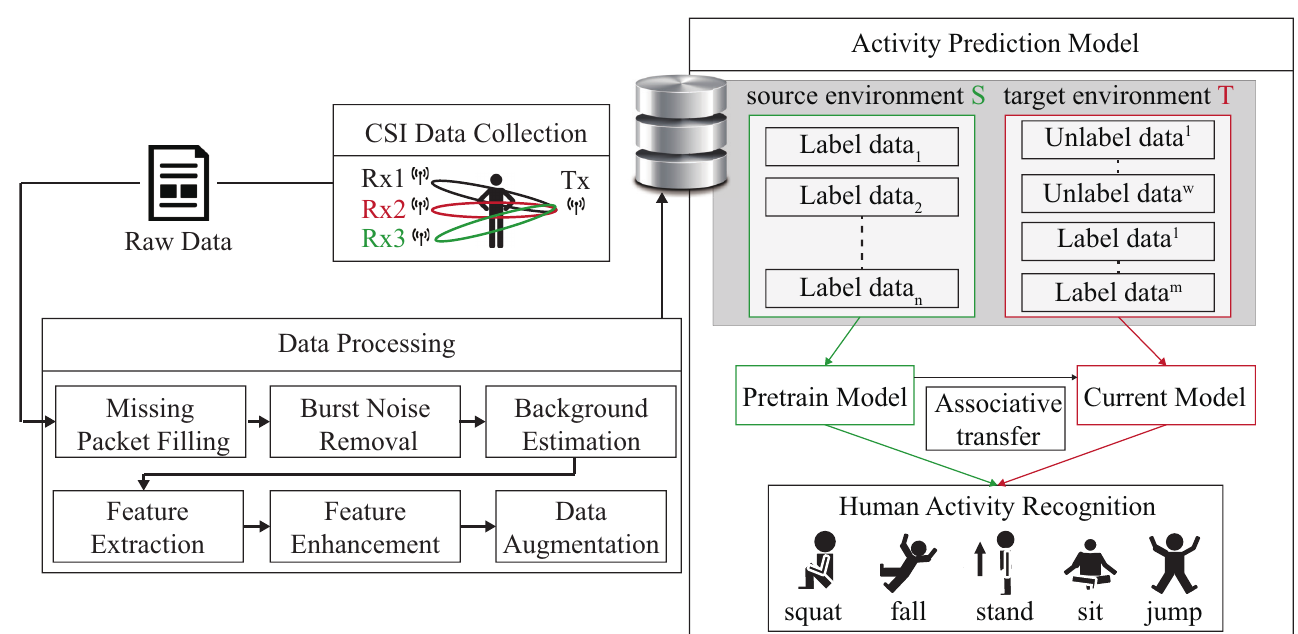
Figure 3. System structure of